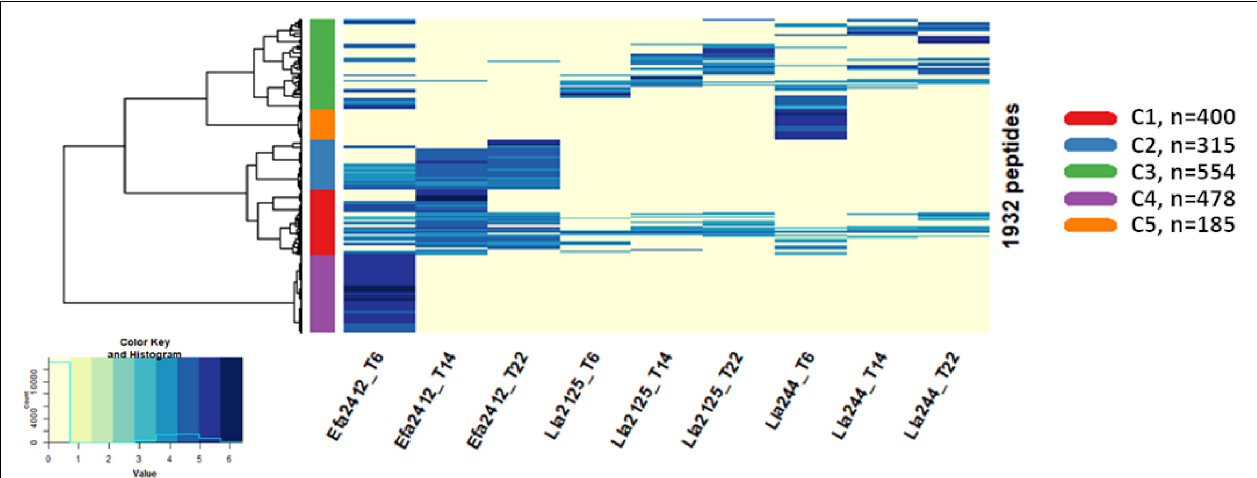
FIGURE 4 | Heatmap of the abundance of the peptides produced by the three donor strains after 6, 14, and 22 h of culture. The color scale represents the mean abundance (after the log Pareto transformation) of the identified